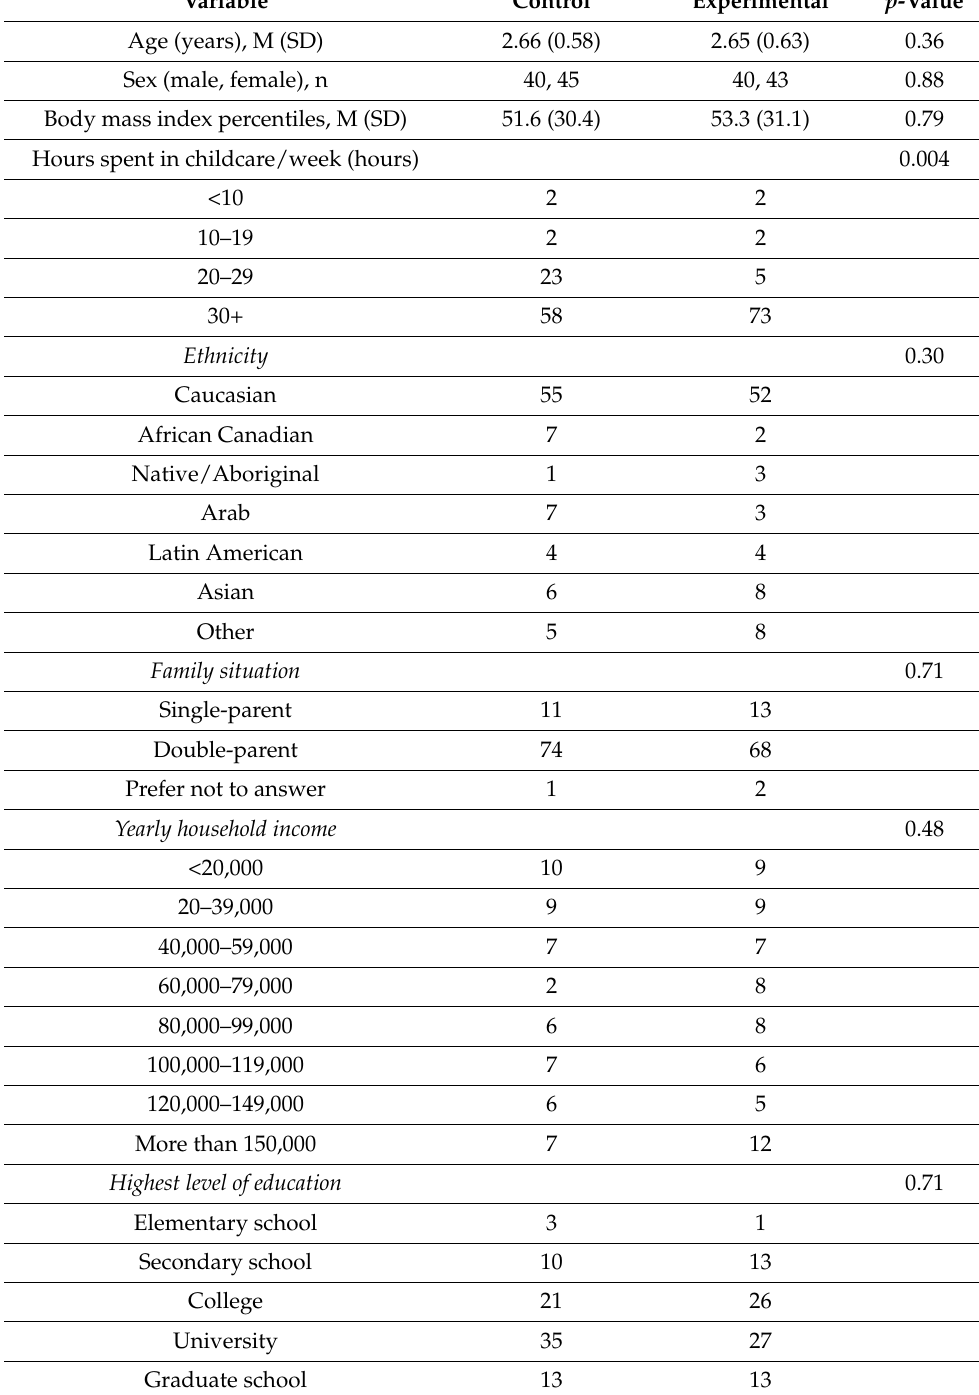
Table 1. Descriptive characteristics of enrolled toddlers and